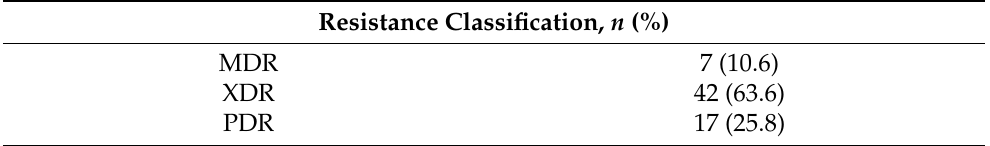
Table 1. Antibiotic resistance classification of multi-resistant GNB ( n = 66).